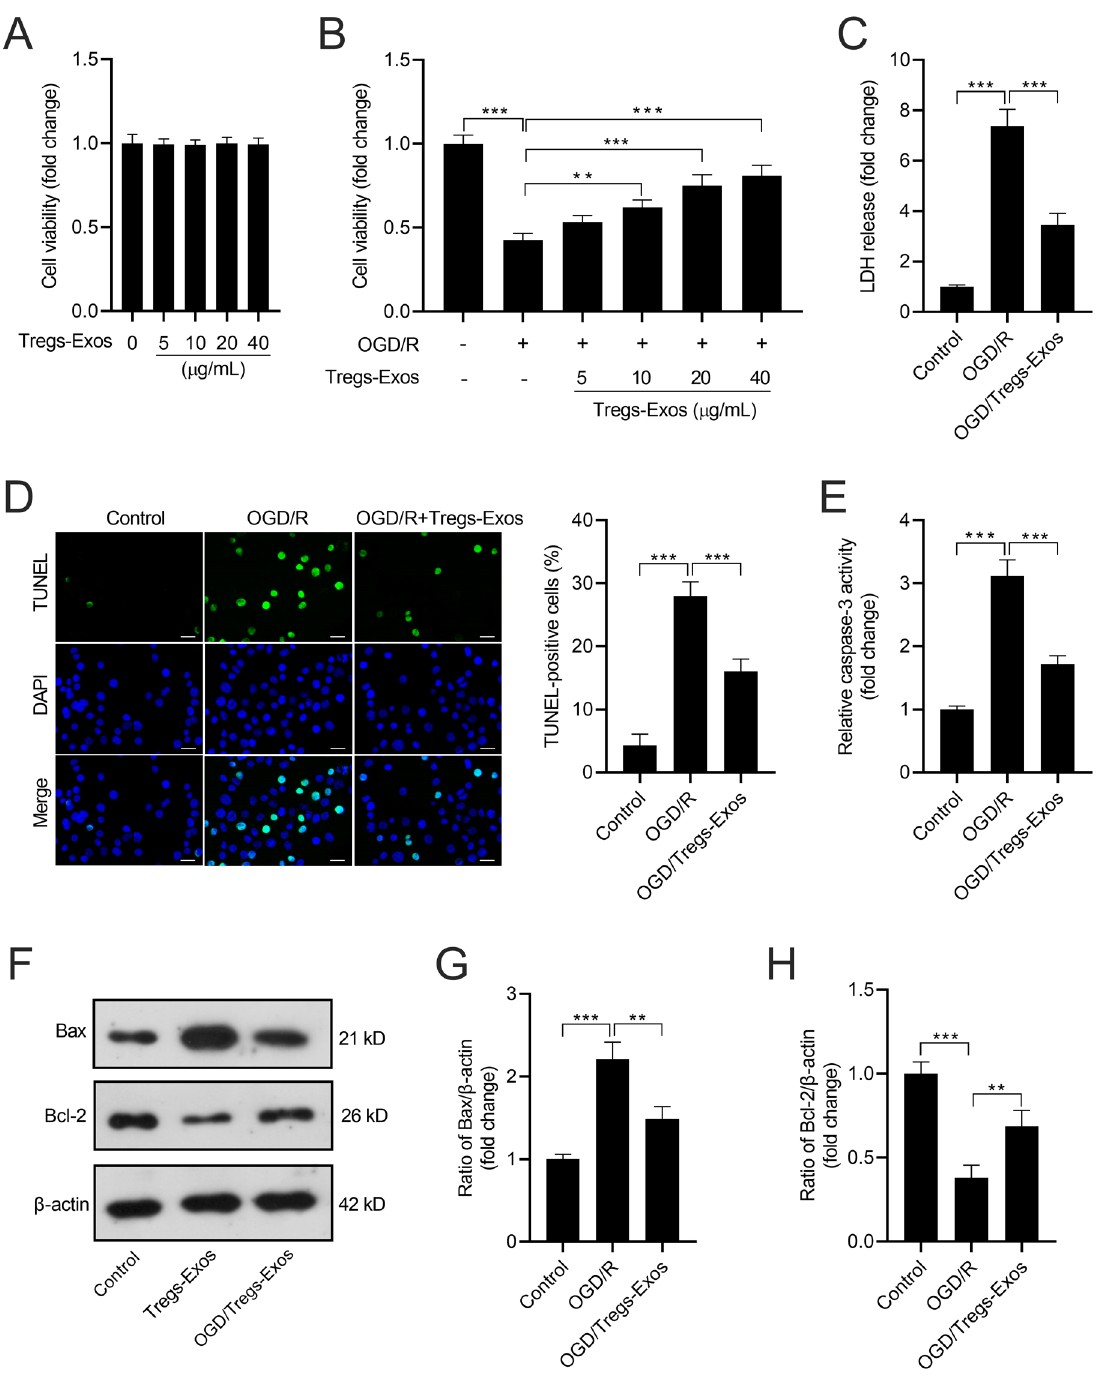
Figure 2 – Tregs-Exos relieves OGD/R-induced apoptosis of BV-2 microglia. (A-B) Cell viability of BV-2 cells was measured by CCK-8 assay. (C) Relative LDH release level in BV-2 cells. (D) TUNEL assay was performed for the determination of apoptotic BV-2 cells. Scale bar: 20 μM. (E) Relative caspase-3 activity in BV-2 cells. (F) Representative images of western blot analysis of Bax and Bcl-2. (G and H) Quantitative analysis results of protein expression. ** p < 0.01, *** p <